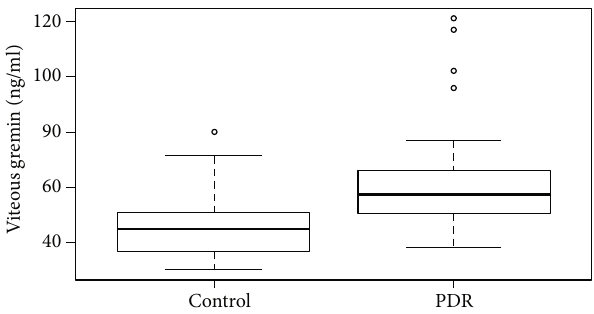
Figure 1: The vitreous concentration of gremlin in patients with PDR and idiopathic epimacular membrane. Box plots showed that the vitreous concentration of gremlin in patients with PDR was signi fi cantly higher than in patients with idiopathic epimacular membrane ( p < 0 : 001 ). PDR represents proliferative diabetic retinopathy; control represents idiopathic epimacular membrane.